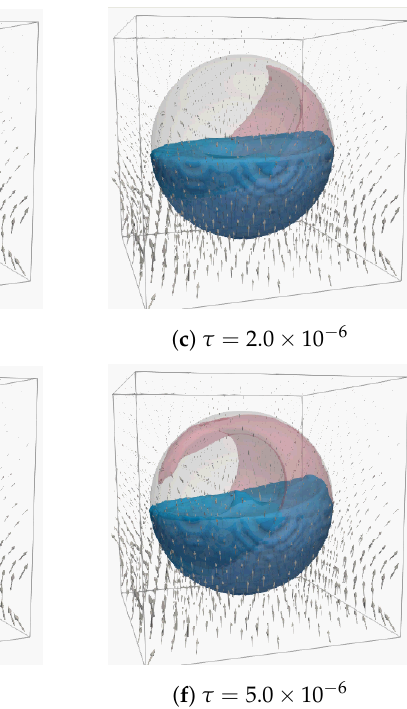
Figure 12. Computational results of Case 3 ( D / L = 2.0, H = 0.0, b c = 1.0 [T]; i.e., coil is larger, closer to the tank and magnetic flux density is medium). The blue color indicates the movement of liquid phase damped by the magnetic force, whereas the pink color indicates that in Case 0 (no magnetic force). The black vectors represent the magnetic field generated by the coil current.